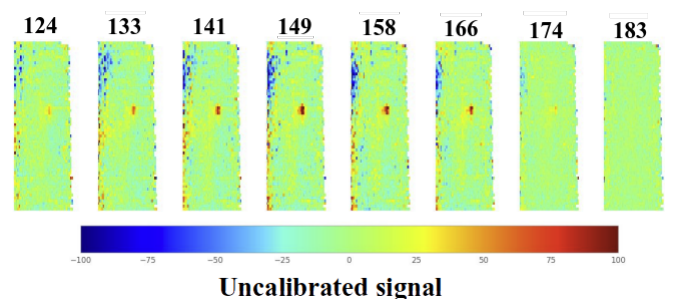
Figure 3. Uncalibrated spectral mapping of Jupiter with 8GHz resolution in frequency. The large bin has been adopted to increase the sensitivity. We show the mean value from all detectors. The central frequency in GHz is given at the top of each